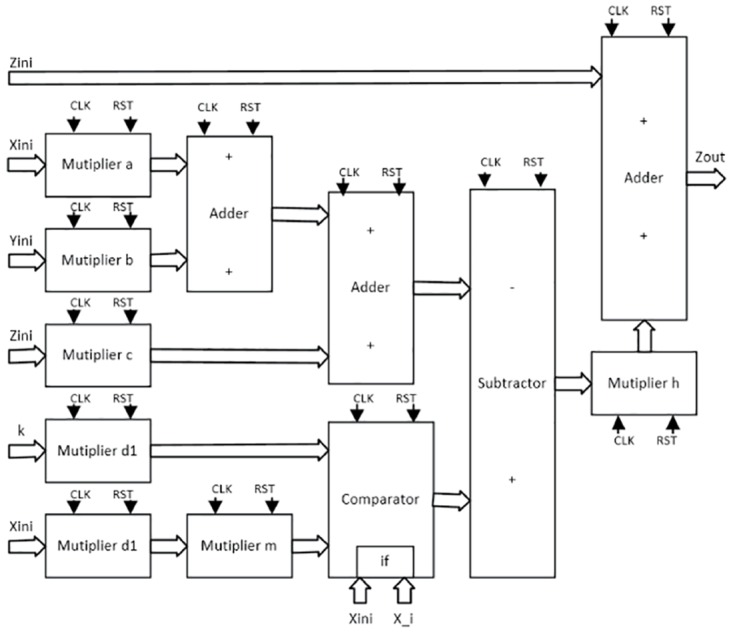
Hardware connection for implementing.z[k + 1] = z[k] + h(−ax[k] − by[k] − cz[k] + d1
f(x[k])) from Eq (10).